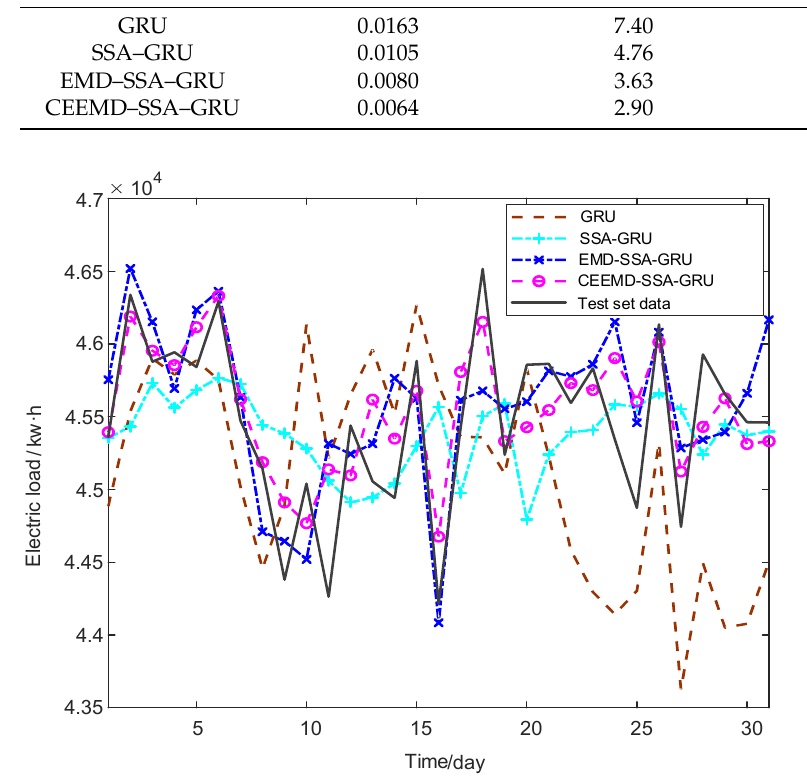
Figure 16. Comparison of prediction curves of four models.